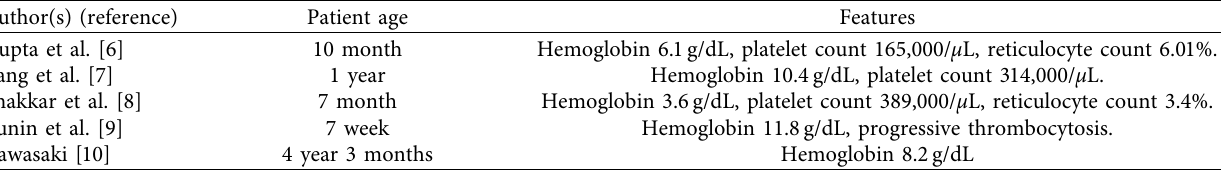
Table 1: Literature review of articles associated with hemolytic anemia and Kawasaki disease.